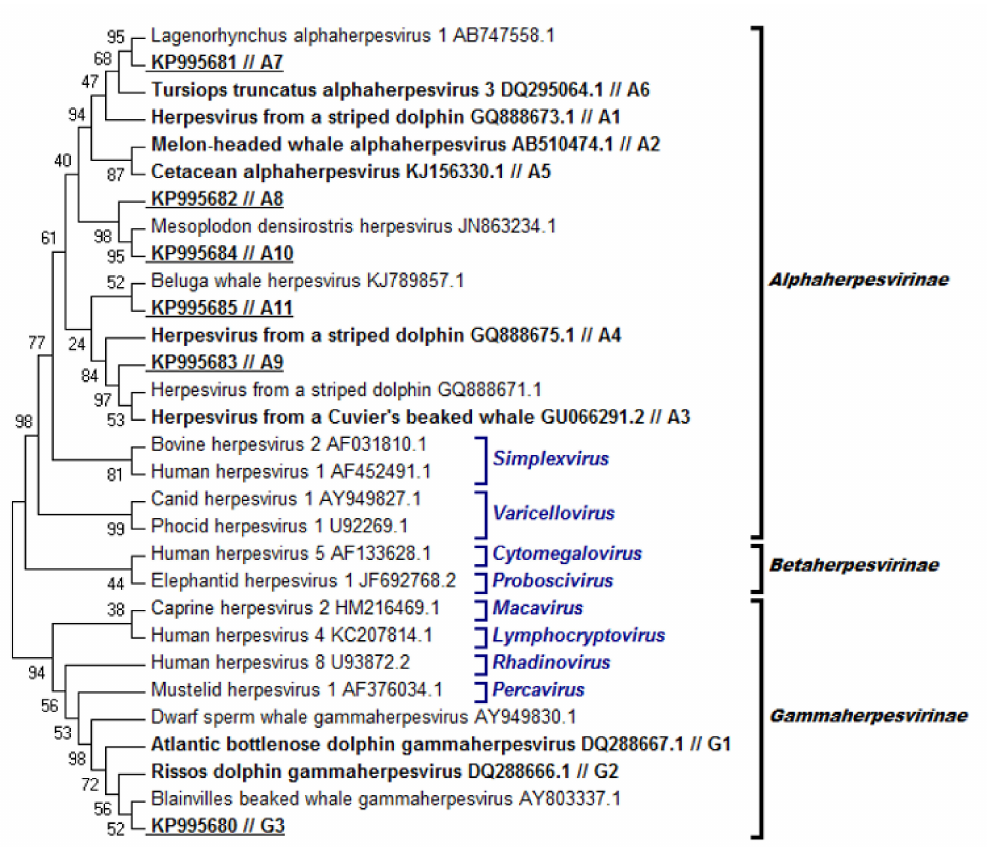
Figure 6. Phylogenetic analysis of HV based on partial sequences of the DNA polymerase gene from different host species. The phylogenetic tree was inferred from deduced amino acid sequences using the maximum likelihood method. Each sequence was named according to the virus and GenBank accession number; sequences registered as undefined HV were denominated as HV from + < common name of the host >. Sequences amplified in this study and the GenBank sequences to which they are identical are marked in bold type and labeled A1 to A11 ( Alphaherpesvirinae ) and G1 to G3 ( Gammaherpesvirinae ). Novel sequences are underlined and indicated together with their GenBank accession number. Sequences were assigned to HV subfamilies and genera according to Davison [28]. Betaherpesvirus sequences served as the outgroup with which to root the phylogram. Tree topology was inferred from p-distances using the maximum likelihood method. Topology reliability was tested by bootstrapping 500 replications, and the results are indicated at the tree